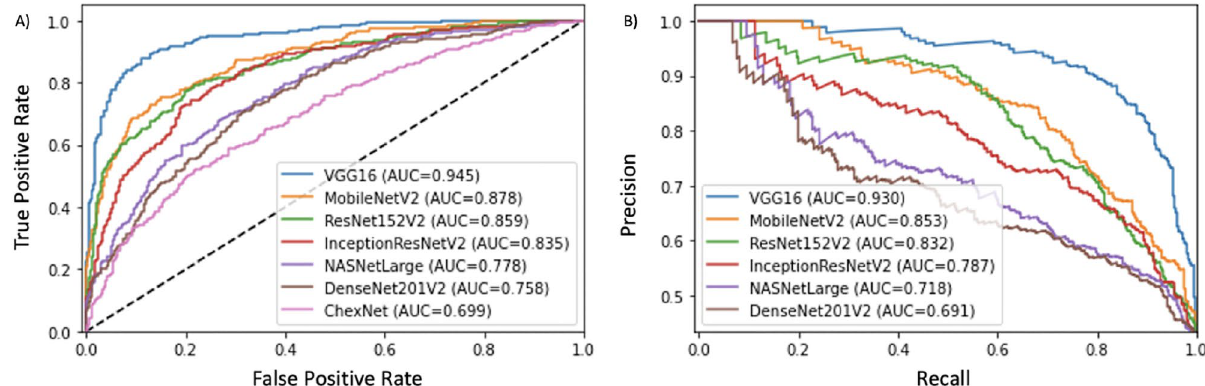
Figure 4. Different deep learning model comparisons are seen with their true positive rate ( A ) and precision ( B ).